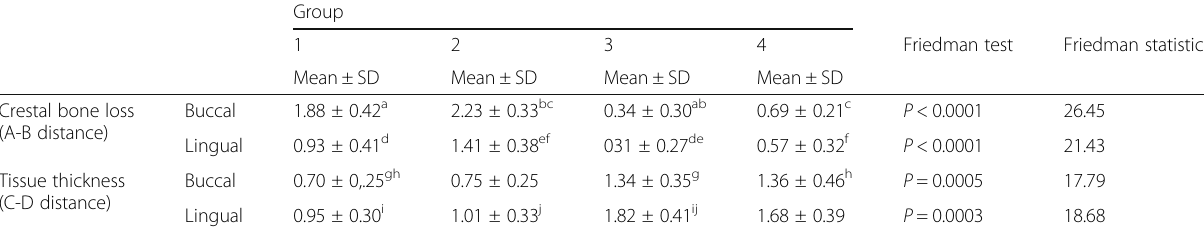
Different superscript letters in the same row indicate significant differences between groups assessed by Dunn ’ s multiple comparison test ( P< 0.05) and Wilcoxon signed rank test for comparison of different groups